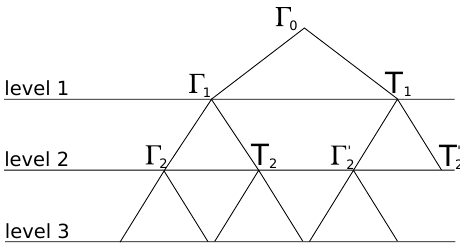
Figure 8. Reflection binary tree data structure + ray order illustration.